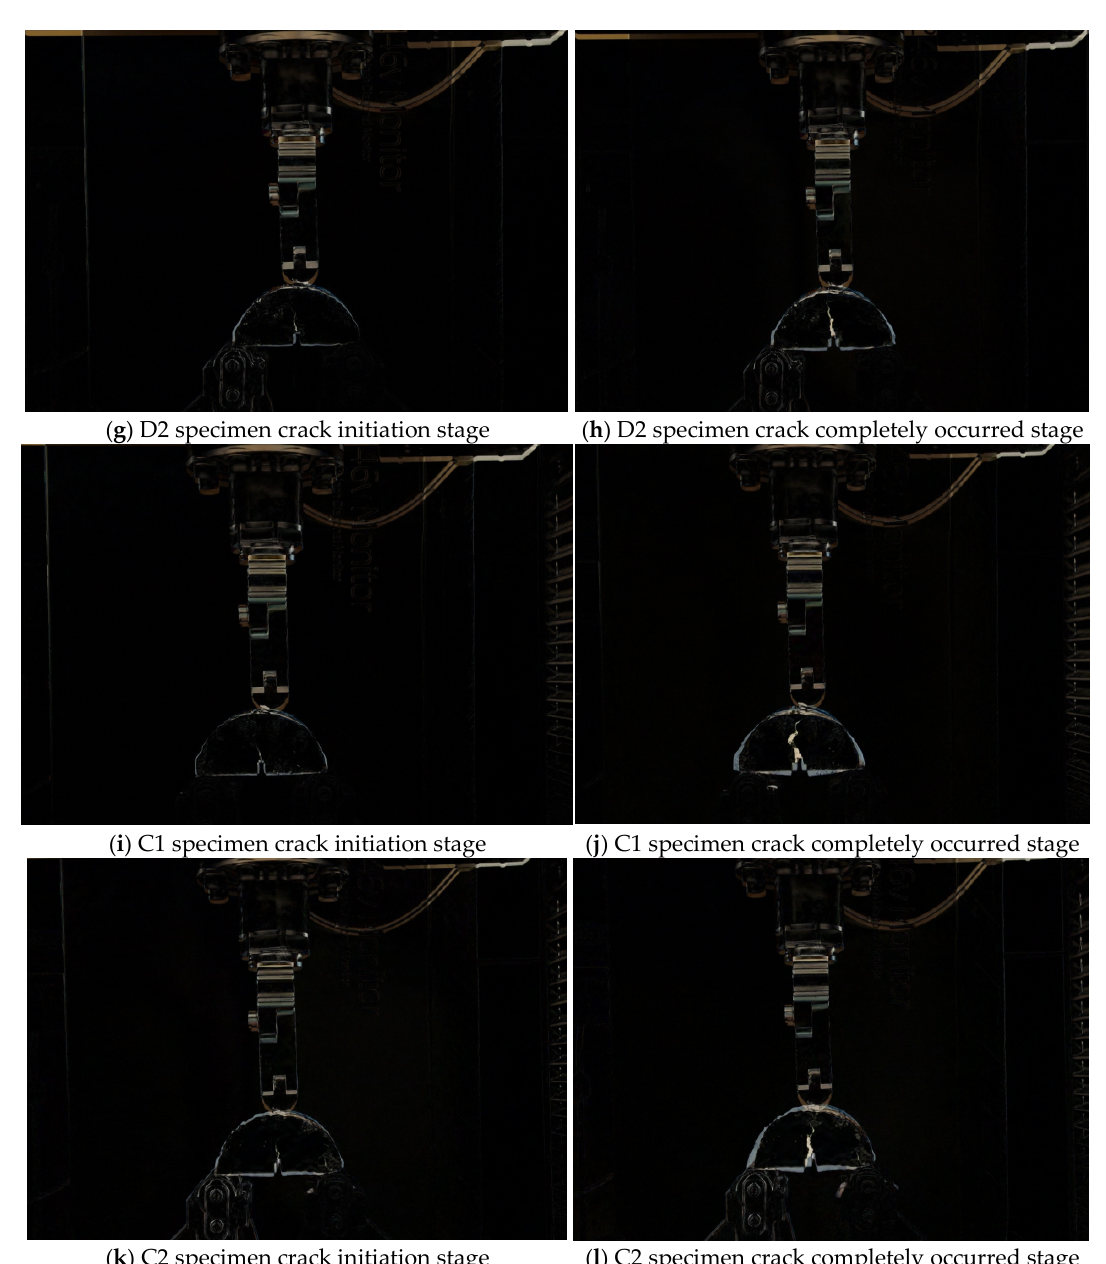
Figure 7. The damage process of SCB specimen with 10 mm opening.